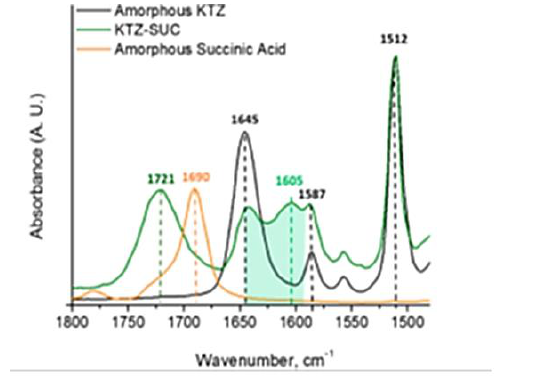
Figure 3. IR spectra of (a) amorphous KTZ, coamorphous KTZ−SUC, amorphous succinic acid (94) Edinger et al. employed the transmission Raman spectroscopy to quantify the amorphization fraction of celecoxib in polyvinylpyrrolidone (PVP) tablet. The transmission Raman spectroscopy provided fast at-line and non-destructive measurements after each microwaving step. The spectrum of amorphous celecoxib shows bathochromic shift of the in-plane bending of the phenyl ring, assigned at 810 cm −1 , to798 cm −1 and a merge with another peak centered at 794 cm −1 as well (95)